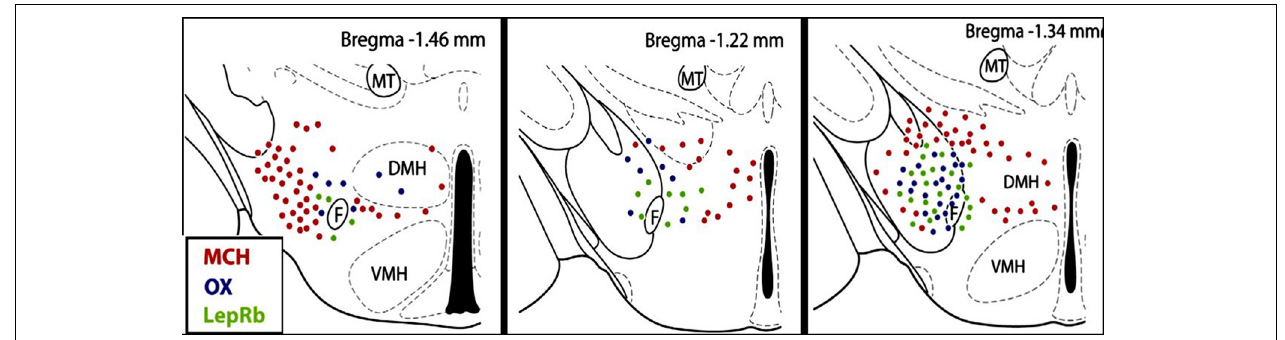
FIGURE 1 | Distribution of orexin (OX), melanin concentrating hormone (MCH) and leptin receptor (LepRb) -expressing neurons in the lateral hypothalamus (LHA). OX, MCH and LepRb-expressing neurons are intermingled in the LHA, but there is no co-expression. Red dots, MCH